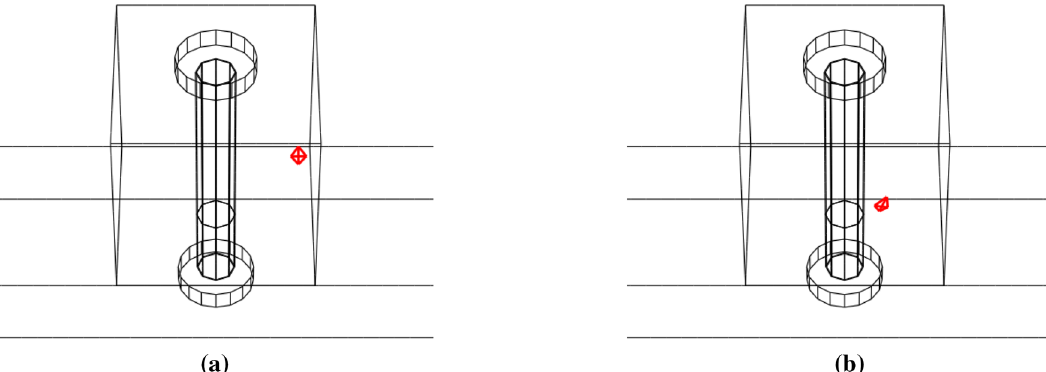
Fig. 5 Location of a element 25,936 and b element 5473